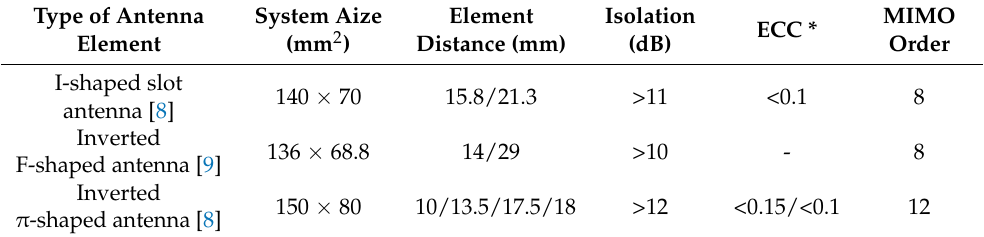
Table 1. Comparison among the referenced techniques of distance optimization. Type of